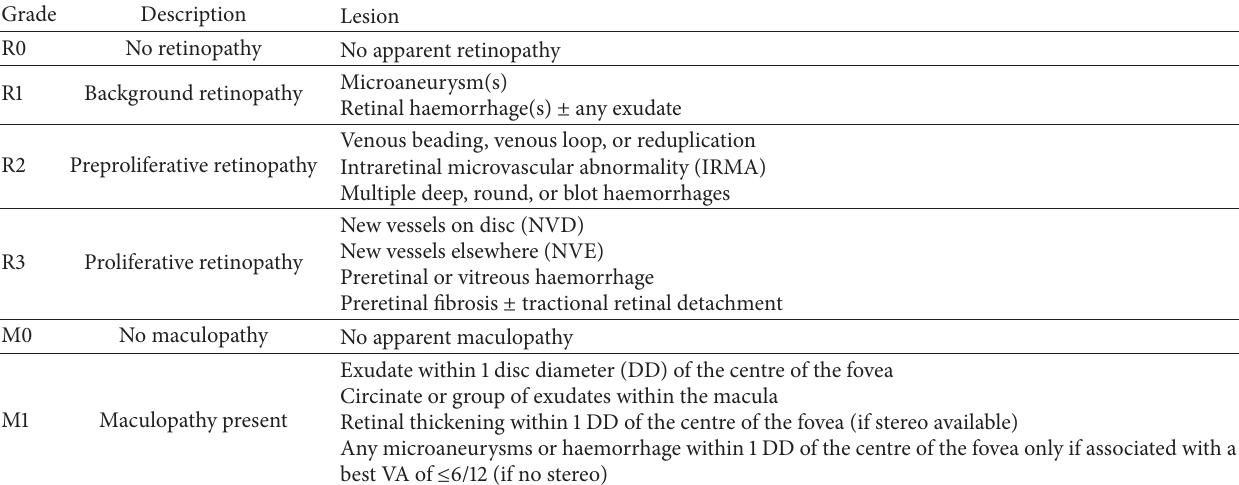
Table 1: Classification of diabetic retinopathy